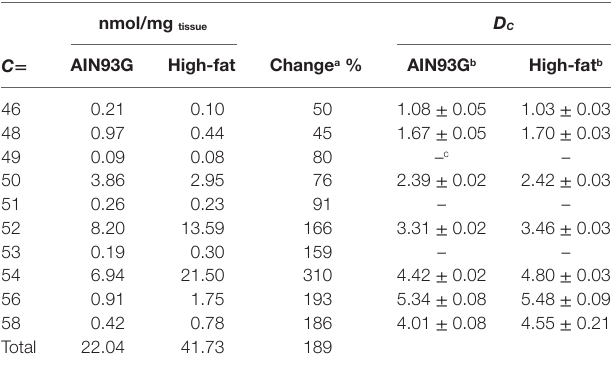
Table 3 | Weighted saturation index ( D C ) of triacylglycerols (TAG) in tumors of Lewis lung carcinoma from mice fed the AIN93G or the high-fat